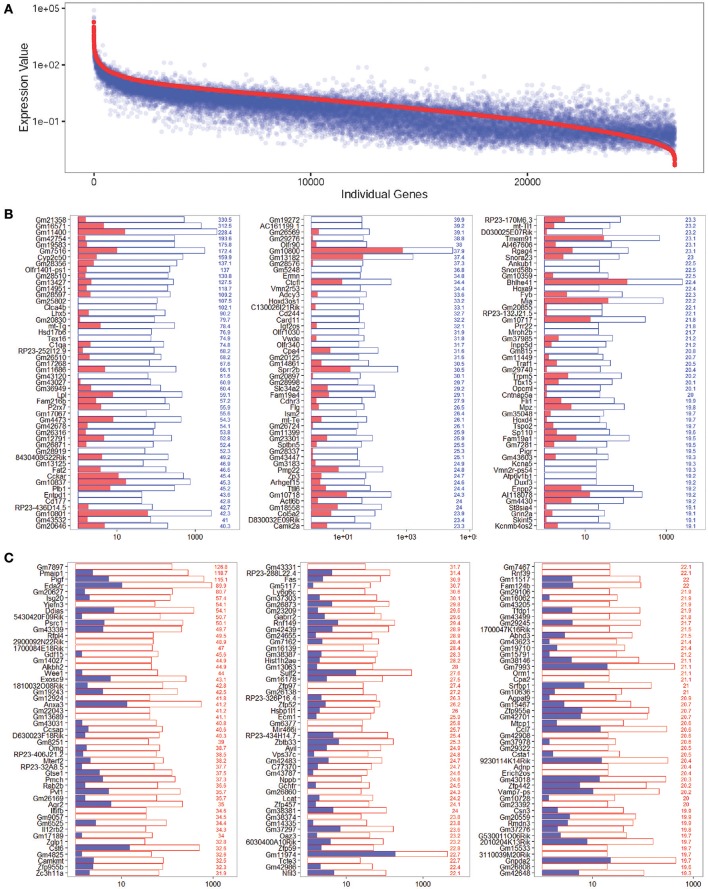
Differentially expressed genes in NLPs and ULPs. (A) All differentially expressed genes in NLPs and ULPs. The red line represents the expression level of transcripts from NLPs, and each blue dot represents the expression level of the same transcript from ULPs. (B) The 150 most differentially expressed genes in ULPs. The blue numbers on the right side of each panel represent the gene expression fold change in ULPs compared to NLPs. (C) The 150 most differentially expressed genes in NLPs. The red numbers on the right side of each panel represent the gene expression fold change in NLPs compared to ULPs.